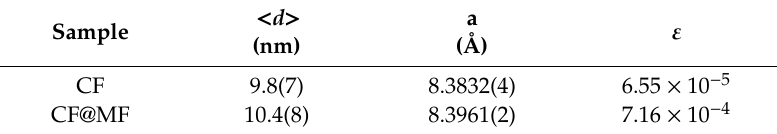
Figure 2. X-ray di ff raction (XRD) patterns of CoFe 2 O 4 (CF)(grey) and CoFe 2 O 4 @MnFe 2 O 4 (CF@MF) (black) nanoparticles (NPs). Table 1. Structural and magnetic parameters. < d >: mean crystallite size; a: lattice parameter; ε : microstrain. Numbers in parentheses indicate the estimated standard deviations of the last significant digit.